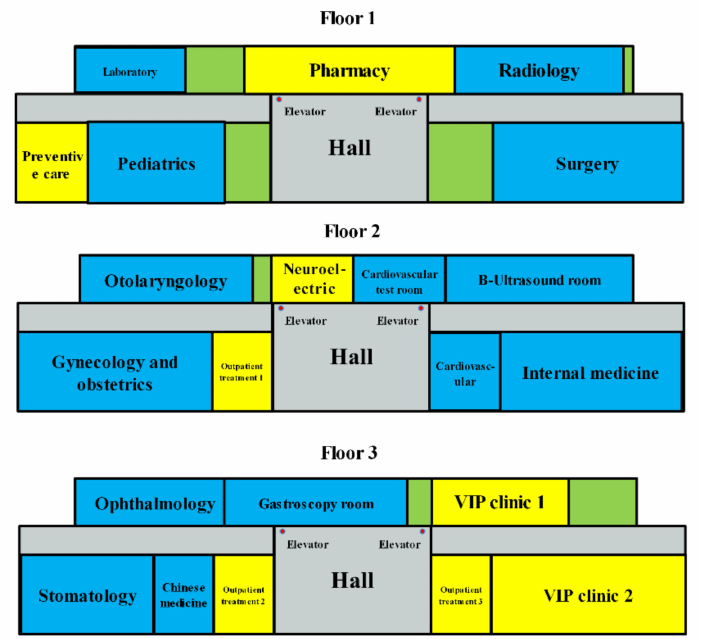
Figure 6. The actual layout of the hospital.